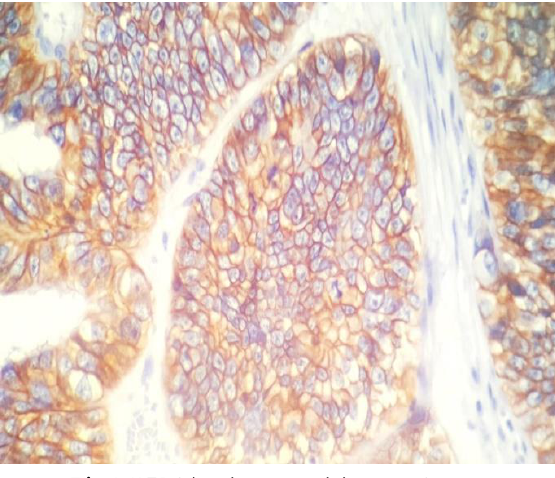
Fig. 1. HER2/neu immunostaining score 3+